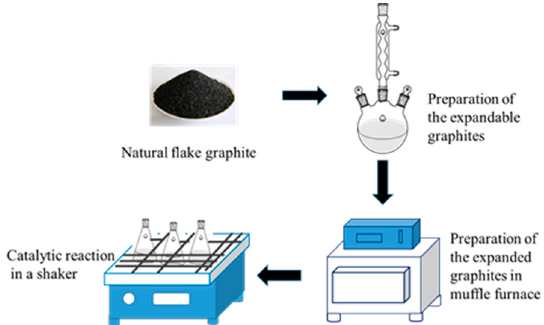
Figure 8. Schematic illustration of the experimental apparatus and procedure.